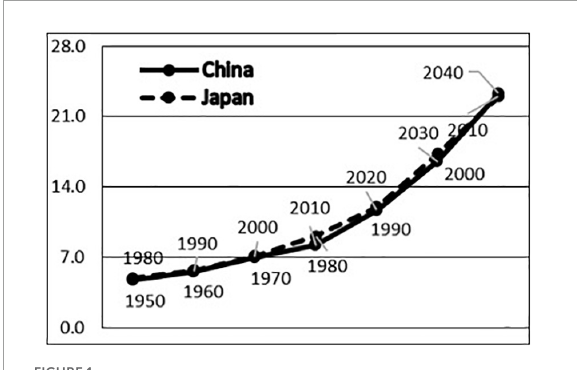
FIGURE1 Comparison on population aging processes in China and